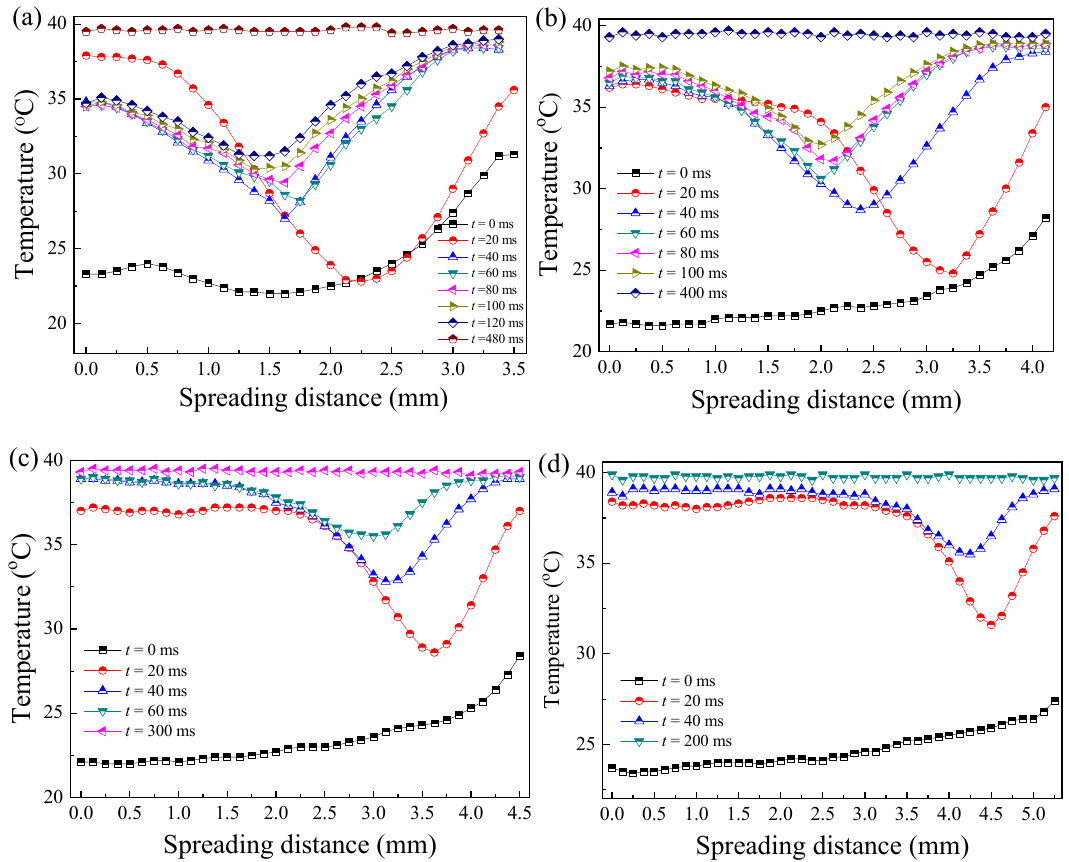
Figure 8. Radial temperature distributions of the spreading droplet on superhydrophilic surface for ( a ) W e = 7.6, T w = 40.0 °C, ( b ) W e = 84.0, T w = 40.0 °C, ( c ) W e = 156.5, T w = 40.0 °C, ( d ) W e = 341.3, T w = 40.0 °C.